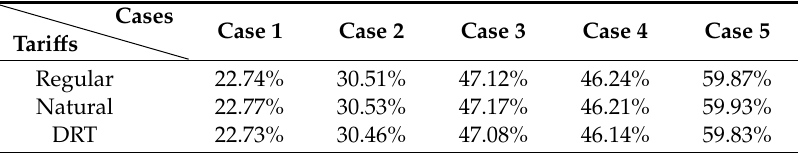
Table 4. Potential reduction of charging